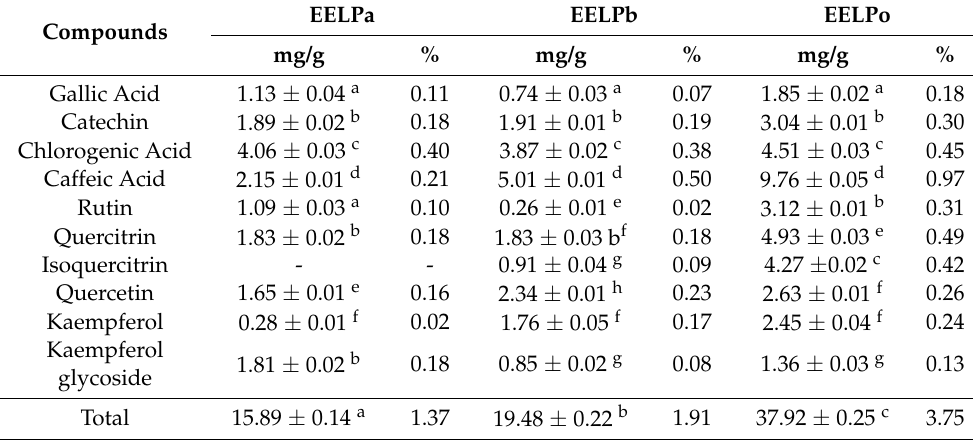
Table 2. Phenolic acids and flavonoids quantified by HPLC/DAD in ethanol extracts of Plectranthus amboinicus , Plectranthus barbatus and Plectranthus ornatus fresh leaves. EELPa Compounds